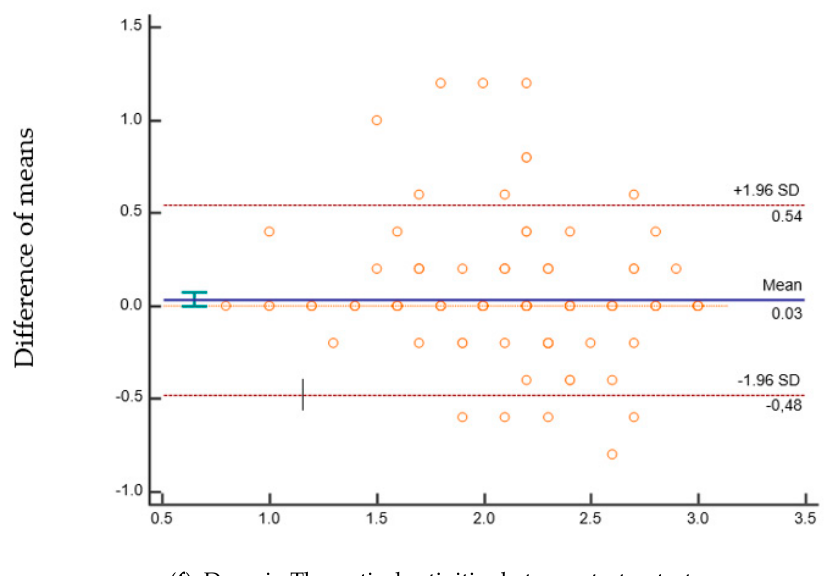
Figure 2. Bland and Altman plots for six domain test retest scores for individual participants according to the ASPS.